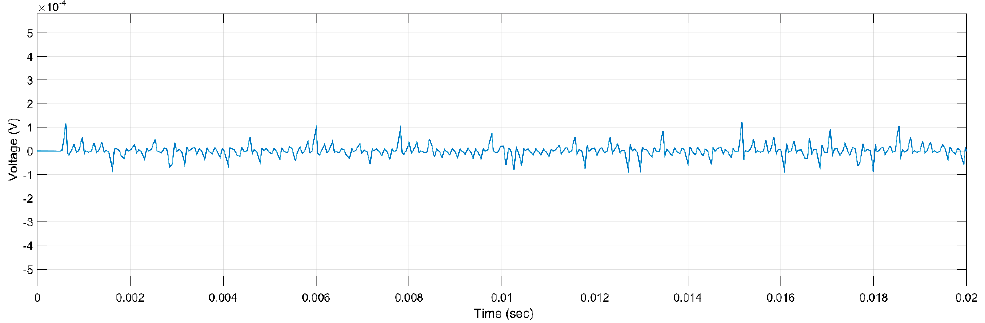
Figure 13. PD Activity for ER, 5 kV, h, r.